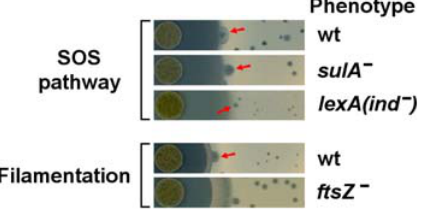
Figure 5. The PAS effect of phage T4 on various E.coli SOS and filamentation mutant strains. T4 was grown on E. coli sulA -inactivated and lexA non-inducible mutant strains (defective SOS systems), as well as an ftsZ -inactivated mutant strain (non-antibiotic induced filamenta- tion), in the presence of disks of cefotaxime (CTX). Isogenic wild-type strains (wt) are also included and representative plaques demonstrating the PAS effect are indicated by red arrows. All plates were photographed at identical magnifications.